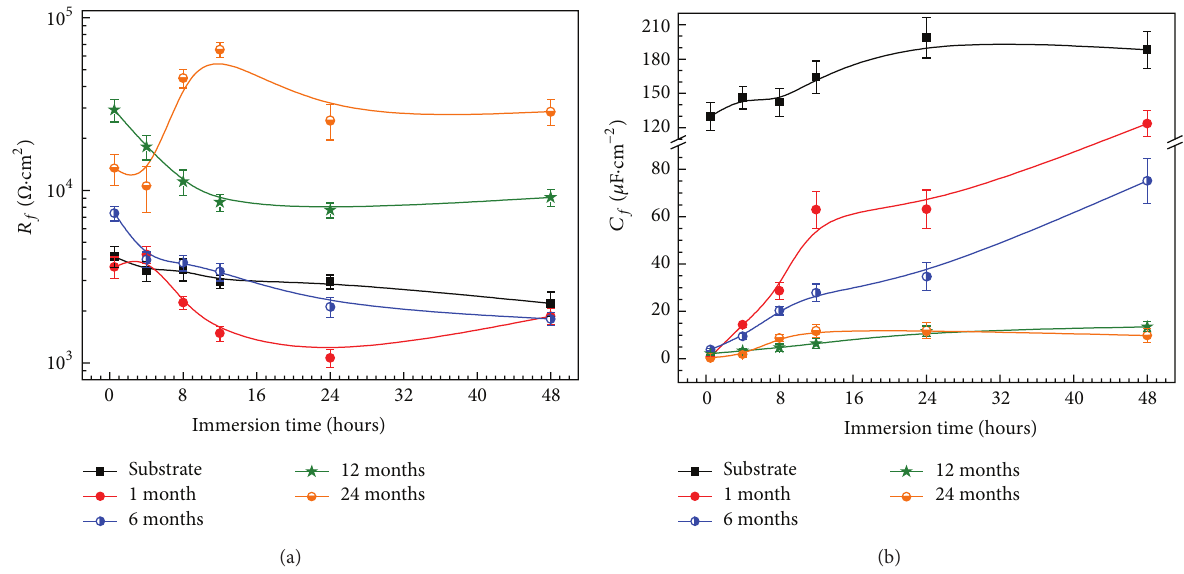
Figure 16: Fitting results of film resistance 𝑅 𝑓 (a) and the calculated capacity 𝐶 𝑓 (b) of the corrosion product layer during immersion test.